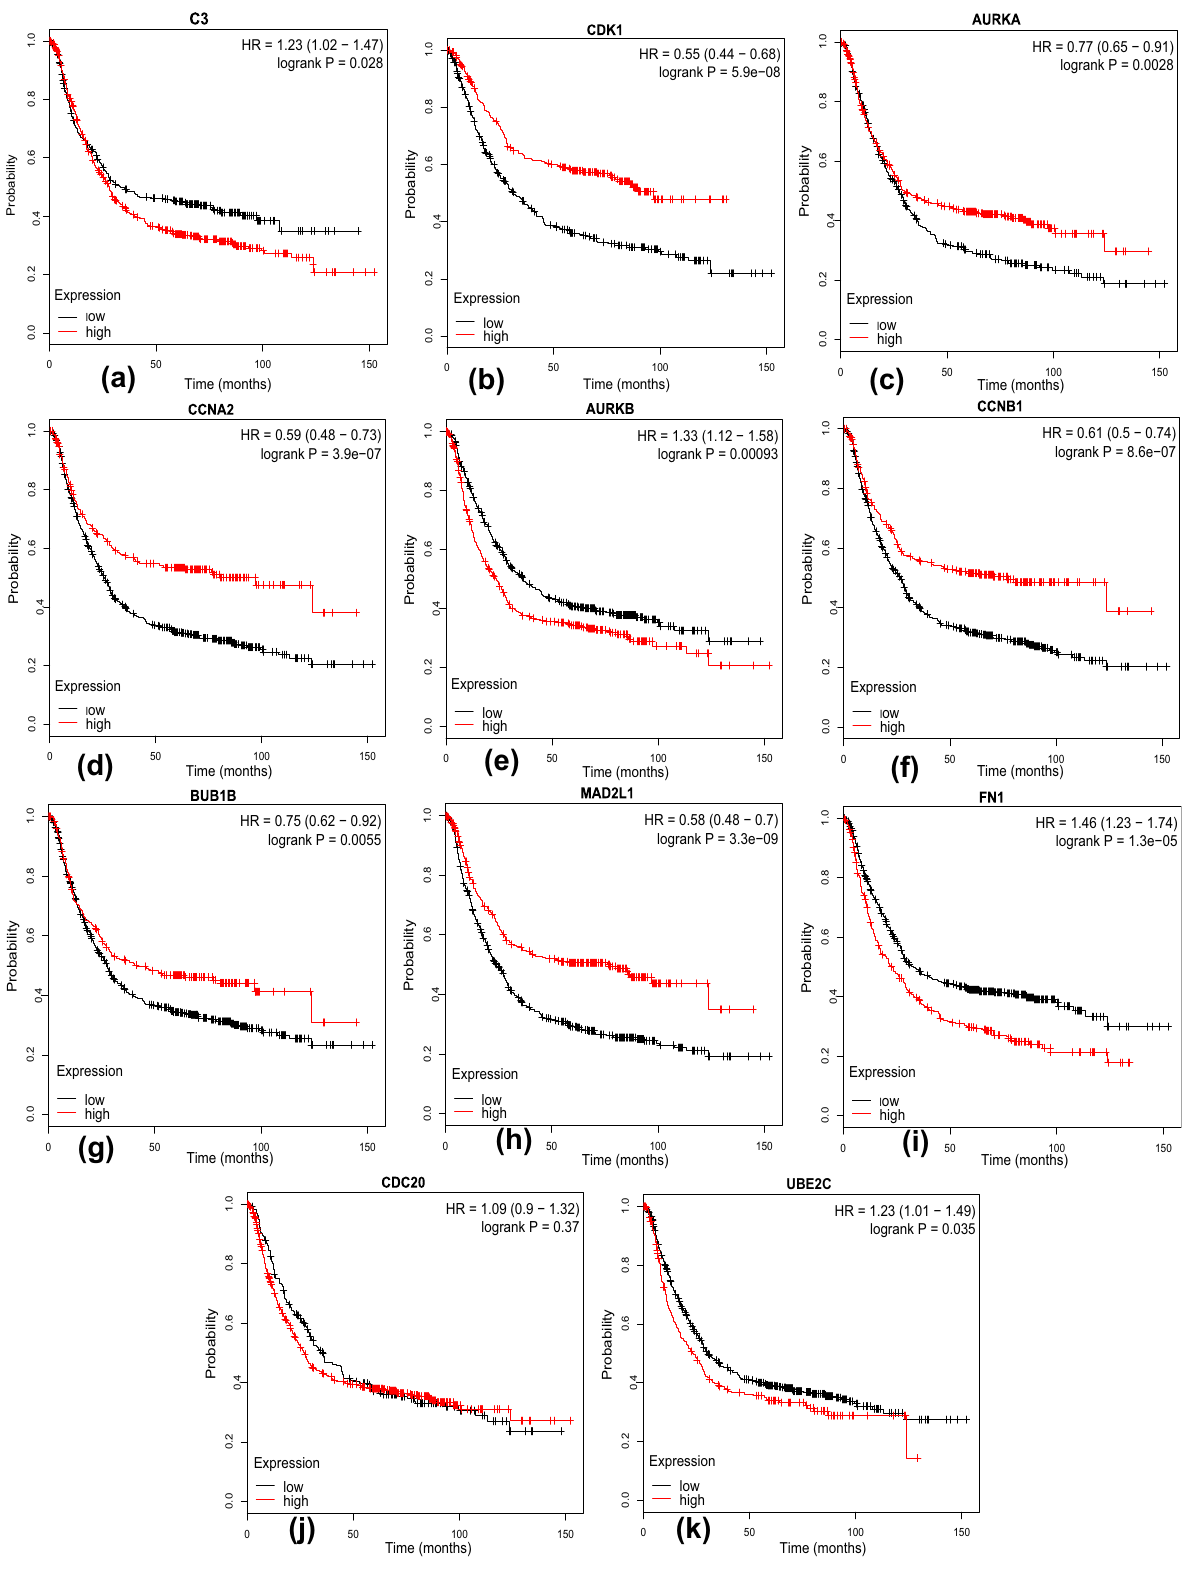
Figure 6. Survival plot of the significant genes by Kaplan Meier test. The Kaplan–Meier test p-value < 0.05: ( a ) C3, ( b ) CDK1, ( c ) AURKA, ( d ) CCNA2, ( e ) AURKB, ( f ) CCNB1, ( g ) BUB1B, ( h ) MAD2L1, ( i ) FN1 and ( k ) UBE2C. The test p-value > 0.05: ( j ) CDC20. [The figures were created by Kaplan–Meier (https ://kmplo t.com/ analy sis/index .php?p=servi ce&cance r=gastr